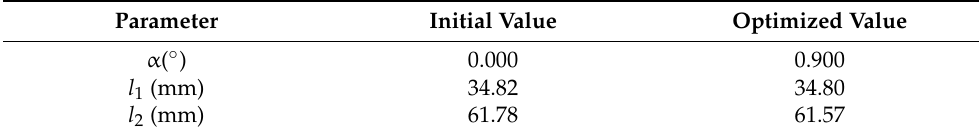
Table 2. Parameters set by means of the optimization routine.